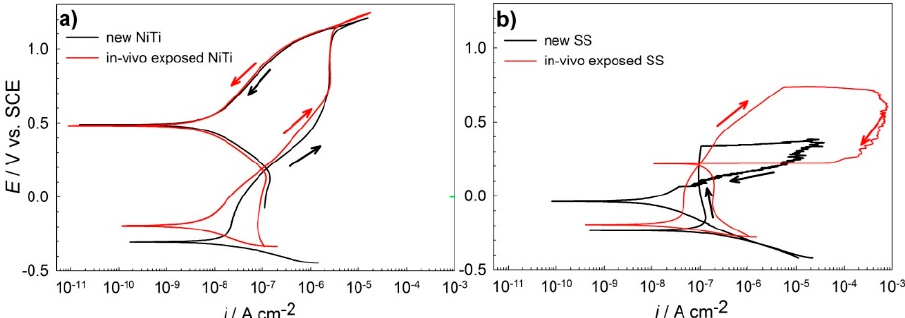
Figure 2. Cyclic potentiodynamic curves for the new (black line) and in vivo exposed (red line) ( a ) NiTi archwires and ( b ) SS archwires in artificial saliva at a scan rate of 1 mV/s.